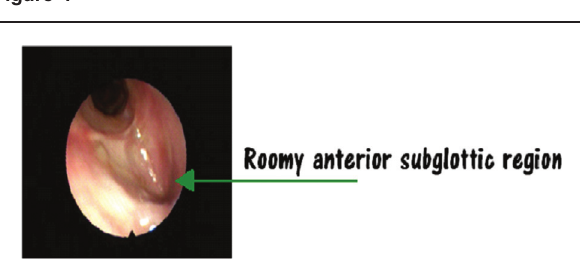
Endoscopic view showing wide roomy anterior subglottic area.